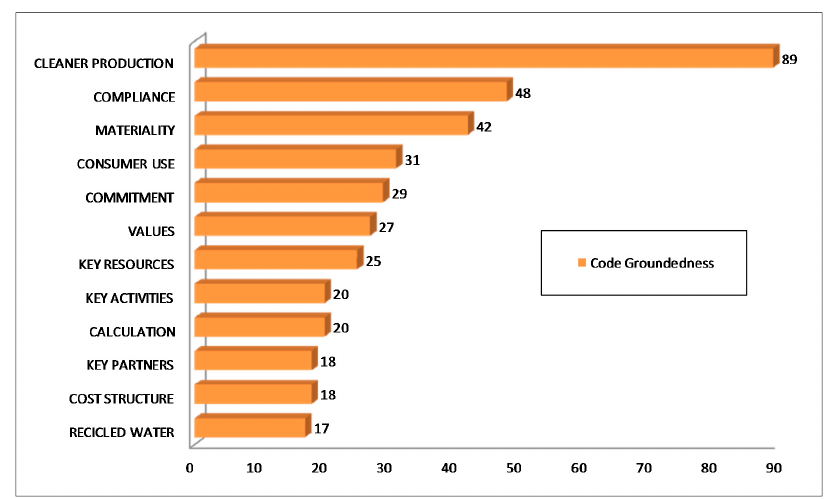
Figure 3. Main topics included in sustainability reports related to water management. ( Source: Own work).